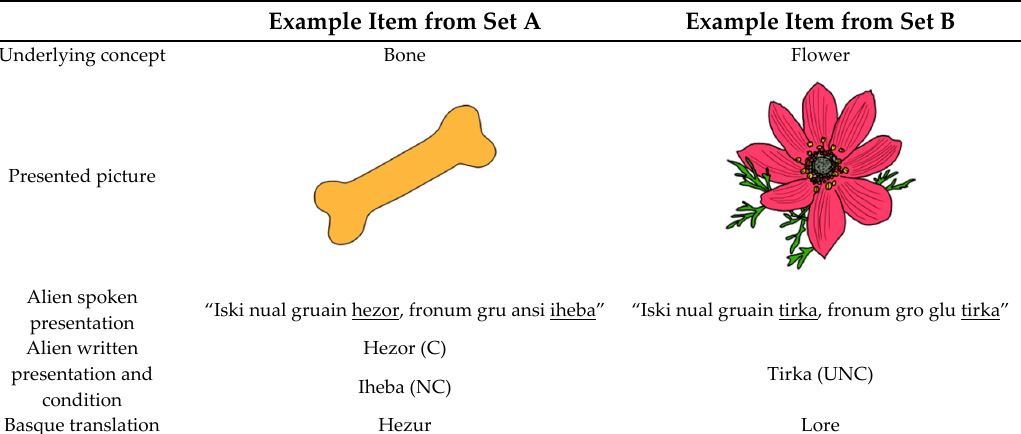
Figure 1. Schematic representation of the presentation of the materials and the experimental